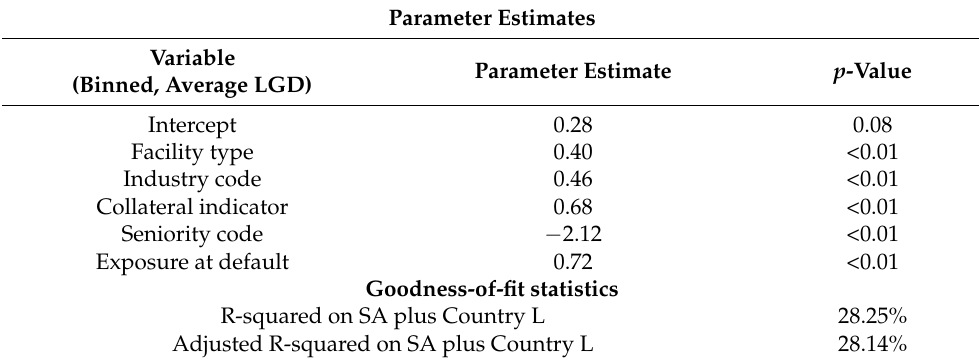
Table 8. Regression of South Africa GCD build data plus Country L (Data set Q + BB).